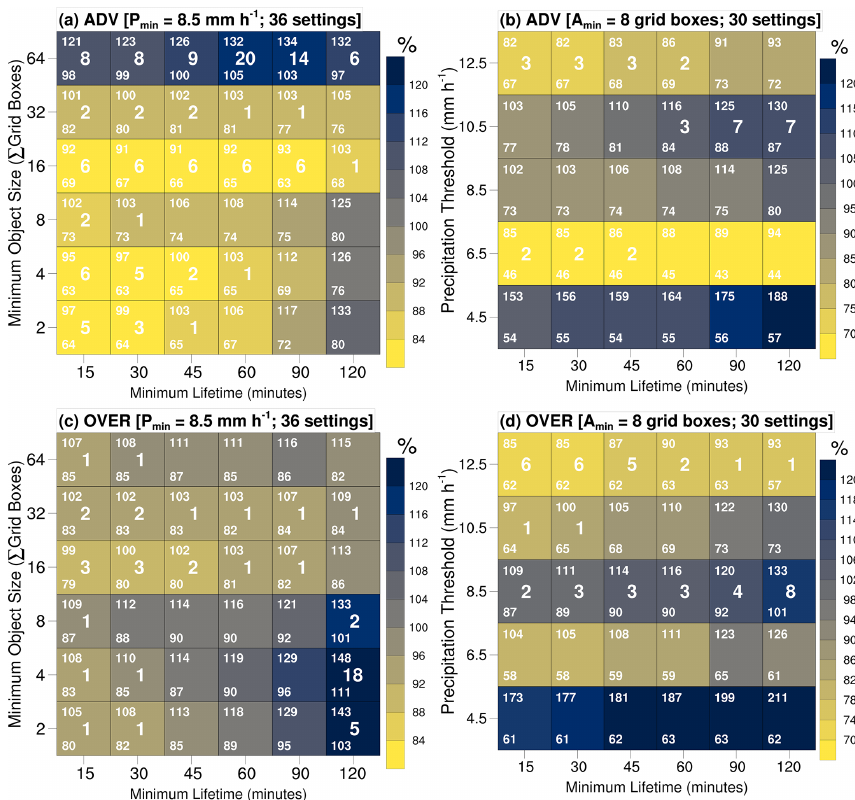
Figure 7. Change (%) in total convective precipitation in response to warming signal, for both algorithms. The change is based on the total precipitation attributable to all identified objects. In panels (a) and (c) , A min and T min are jointly varied, with P min at its reference value. In panels (b) and (d) , P min and T min are jointly varied, with A min at its reference value. Confidence intervals, computed as in Sect. 3.4, are given in the left-hand corners of each box. Statistically significant differences are denoted by a number in the middle of each square, as in Fig. 6. For example, for the case (c) OVER, A min = 2 grid boxes and T min = 120min, the number 5 is present: this means that the change signal for this combination has a statistically significant difference to 5 of the remaining 35 configurations in (c) . Note different colour-bar minima for panels (a, c) and (b, d)